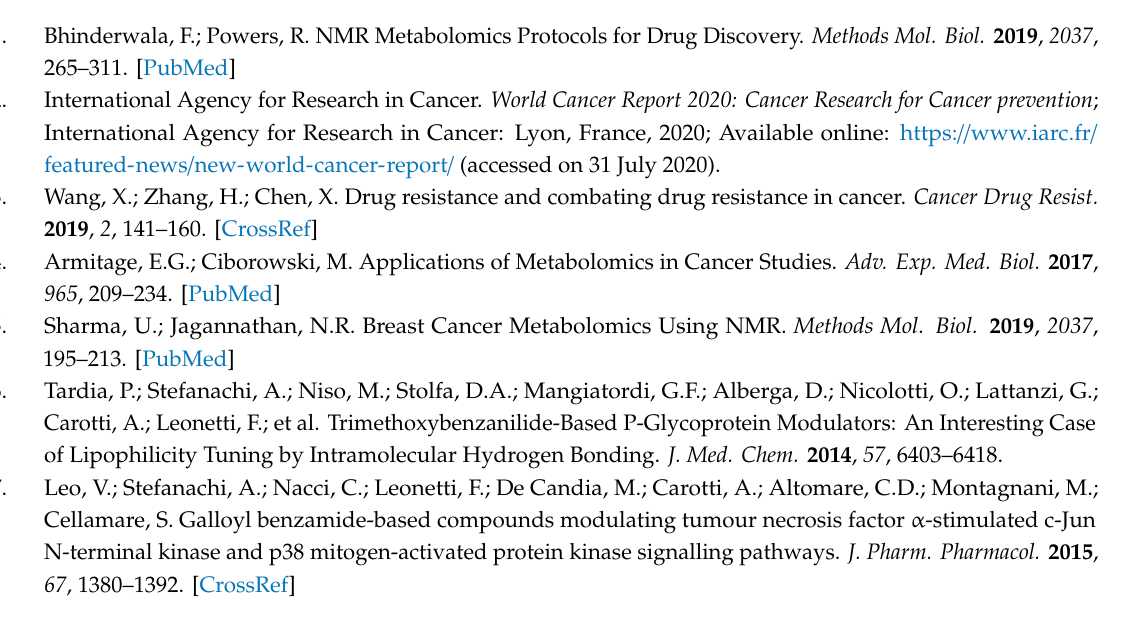
Supplementary Materials: The following are available online, Figure S1: Representative one-dimensional 600 MHz 1 H-NMR of ZGCPPR and CPMG spectra for lysate sample, Figure S2: Validation plot of 20 permutation [2], Table S1: Chemical shifts ( 1 H, ppm) and assignment of metabolite resonances identified in the 600 MHz 1 H spectra of cell lysates (Letters in parentheses indicate the peak multiplicities; s, singlet; d, doublet; dd: doublet of doublet; t, triplet; q, quartet; m, multiplet; bs, broad signals), a : AXP: can be adenosine mono-, di-, triphosphate; UDP-X can be UDP-glucose, UDP-galactose; UDP-Gluc-Nac [1], Table S2: Permutation test results of established OPLS-DA models: CDDP vs K (A) DT8 vs K (B) and (C) VIN vs K. Permutation test was used to check the validity of OPLS models. The intercept is a measure of the overfit [2].